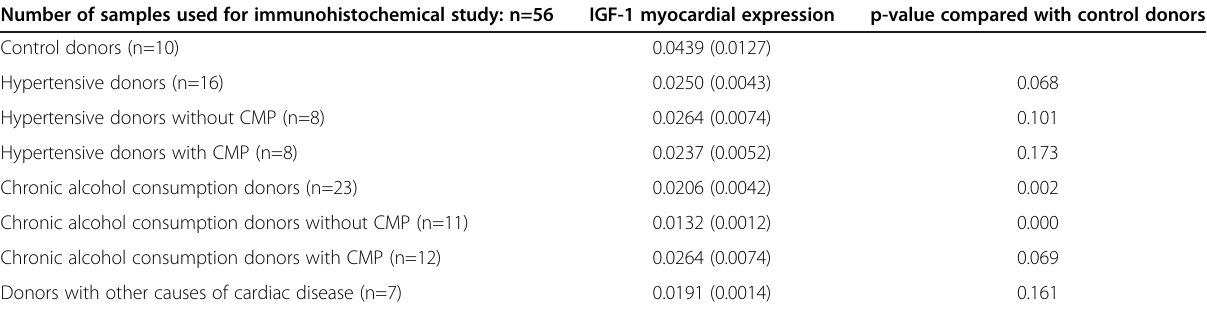
Table 2 Comparison of myocardial immunohistochemmical studies in IGF-1 expression between the different groups Number of samples used for immunohistochemical study: n=56 IGF-1 myocardial